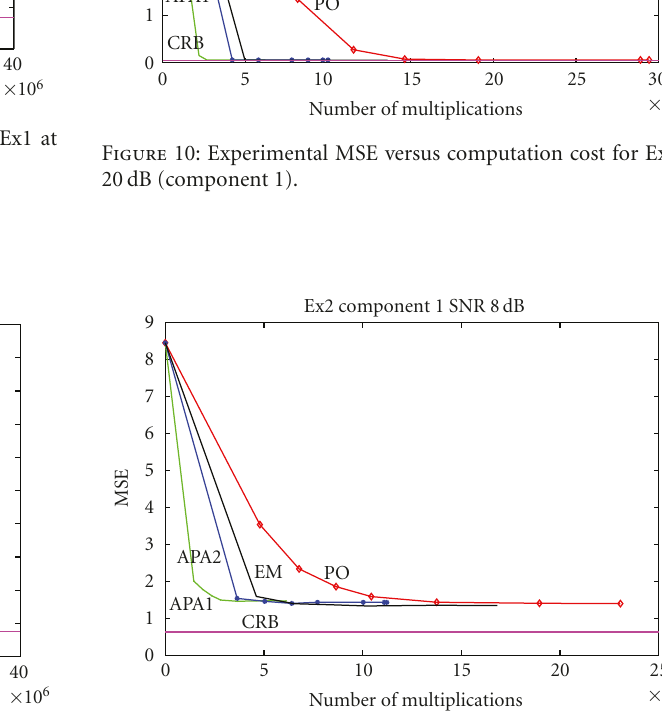
Figure 11: Experimental MSE versus computation cost for Ex2 at 8dB (component